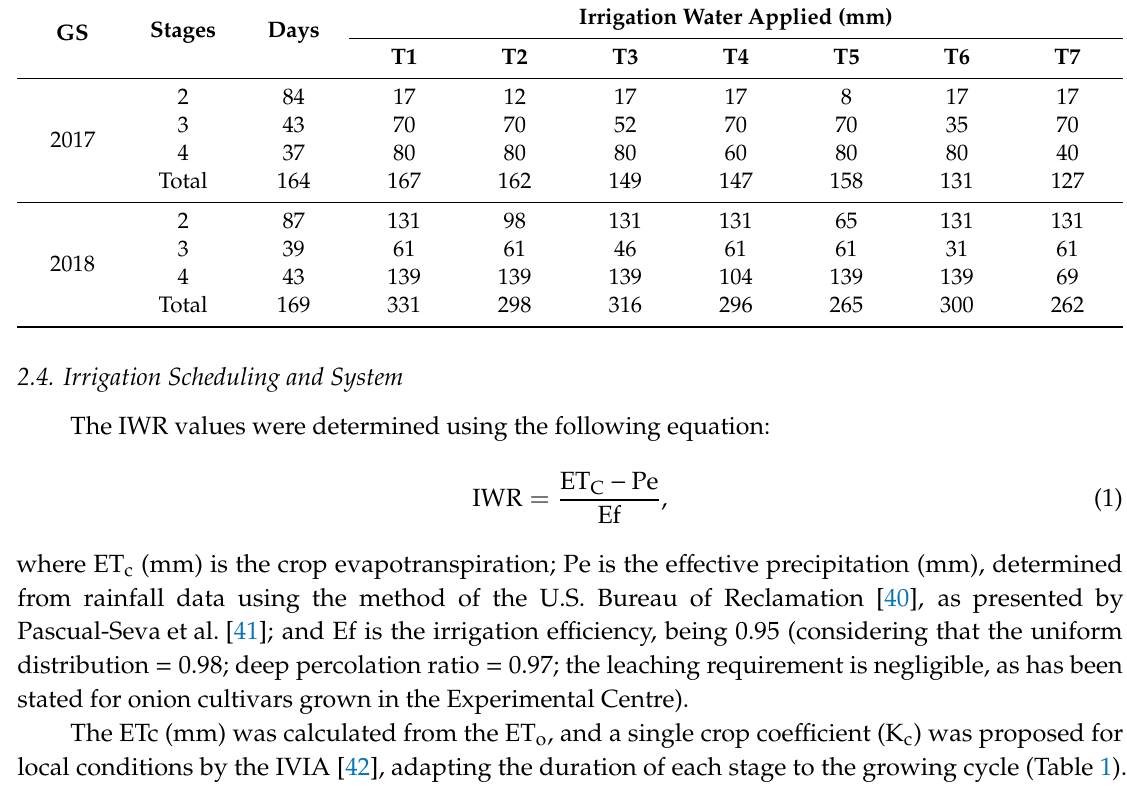
Table 1. Duration (days) and irrigation water applied (mm) at vegetative growth (2), bulbing (3), and bulb ripening (4) stages in each irrigation strategy (T1–T7) during the 2017 (4 November–27 April) and 2018 (30 October–30 April) growing seasons